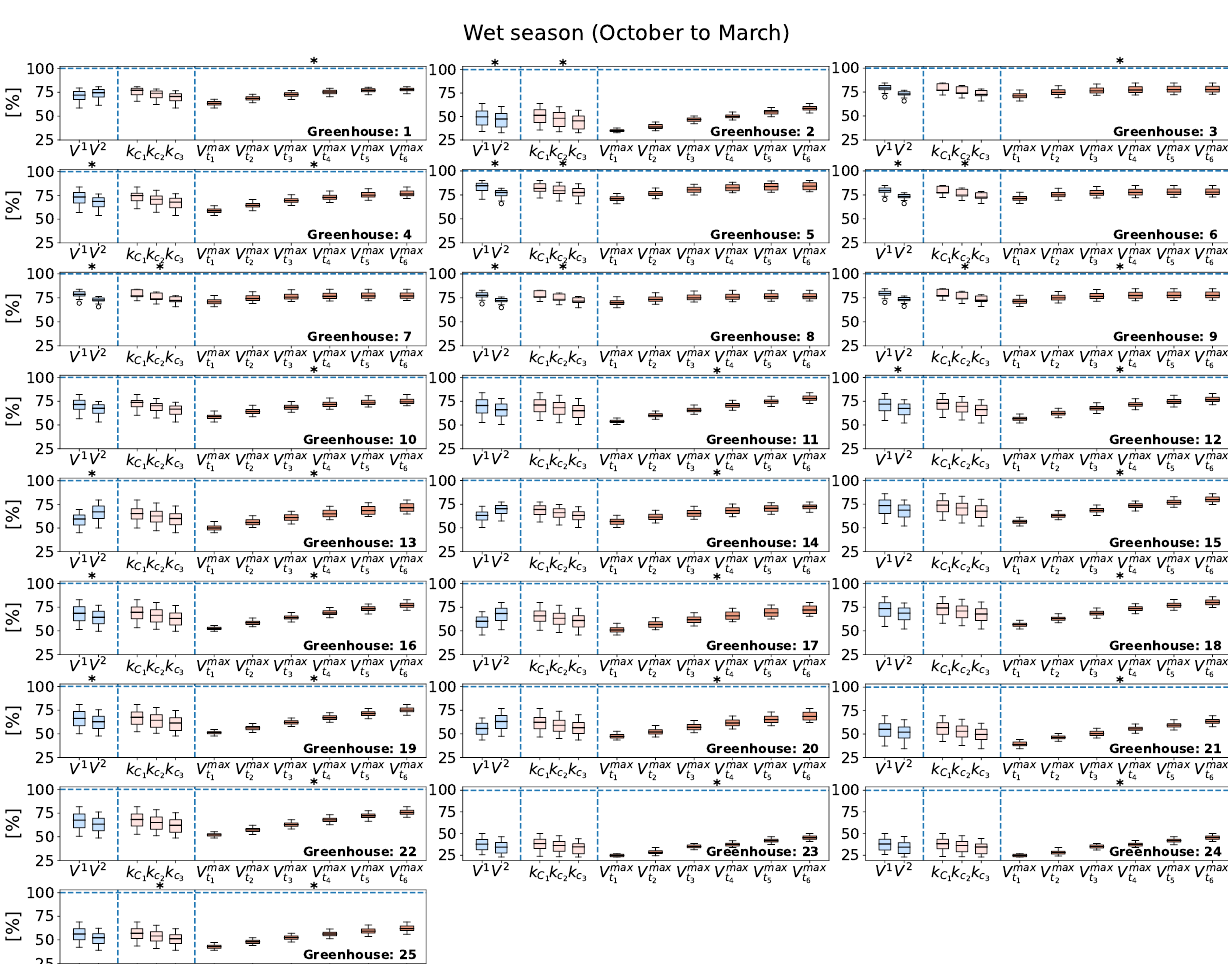
Figure 9. Box plots of the mean percentage of satisfied water demand during the wet season, October to March ( y -axis) for each greenhouse and for each parameter included in Type 2 simulations. Note that box plots reflect changes when one parameter is modified while the others remain fixed. The parameters are: 10-year time window of rainfall ( W 1 or W 2 , depending on the beginning of time = 0.8, series, summer or winter, according to Table 2) depicted by blue boxes; the crop coefficient ( k c 1 = 0.9, k c = 1 ), depicted by pink boxes; and the maximum capacity of water tanks: 300 L, 450 L, k c 2 3 650 L, 900 L, 1200 L, and 1600 L, depicted by orange boxes. For all simulations, the runoff coefficient is fixed ( C r = 0.9). Note that each parameter is separated by vertical dashed lines. The statistical significance of obtained values for the different set of parameters has been calculated using a t -test when we compare two factors, and through an ANOVA one-directional (F-test) when the number of factors is larger than two, which occurs for the crop coefficient ( k c ) and the maximum capacity of the i tank ( V max ). The black asterisks that sometimes appear above box plots indicate when the difference t i between the means is significant at 95%, i.e., p value ≤